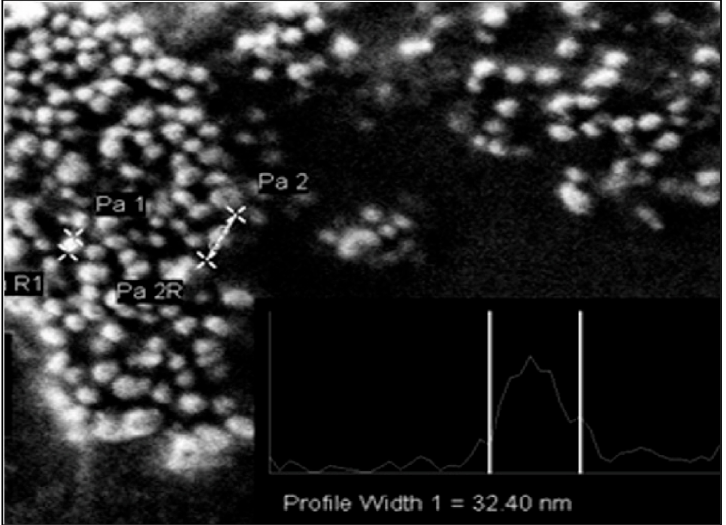
Figure 5. SEM image of CB-AgNPs obtained from Cleome brachycarpa